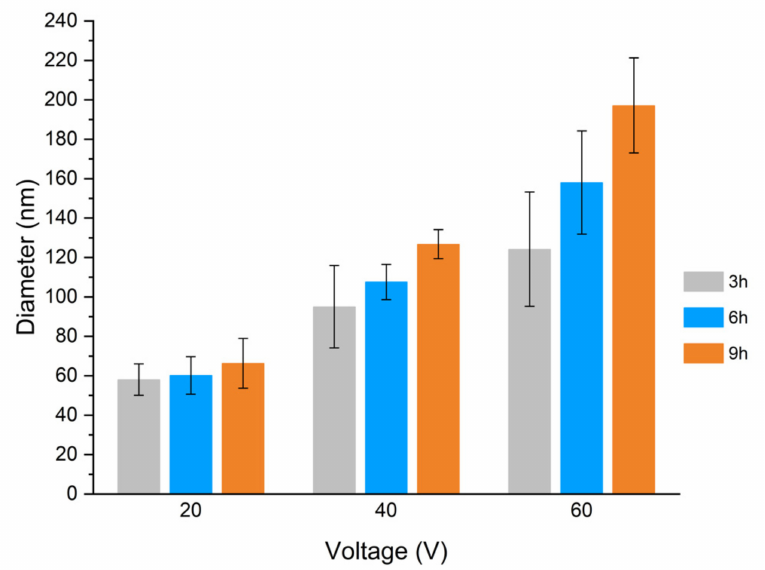
Figure 9. Average inner diameter of TiO 2 nanotubes produced over CP-Ti as a function of the applied potential, for anodization times of 3 h, 6 h, and 9